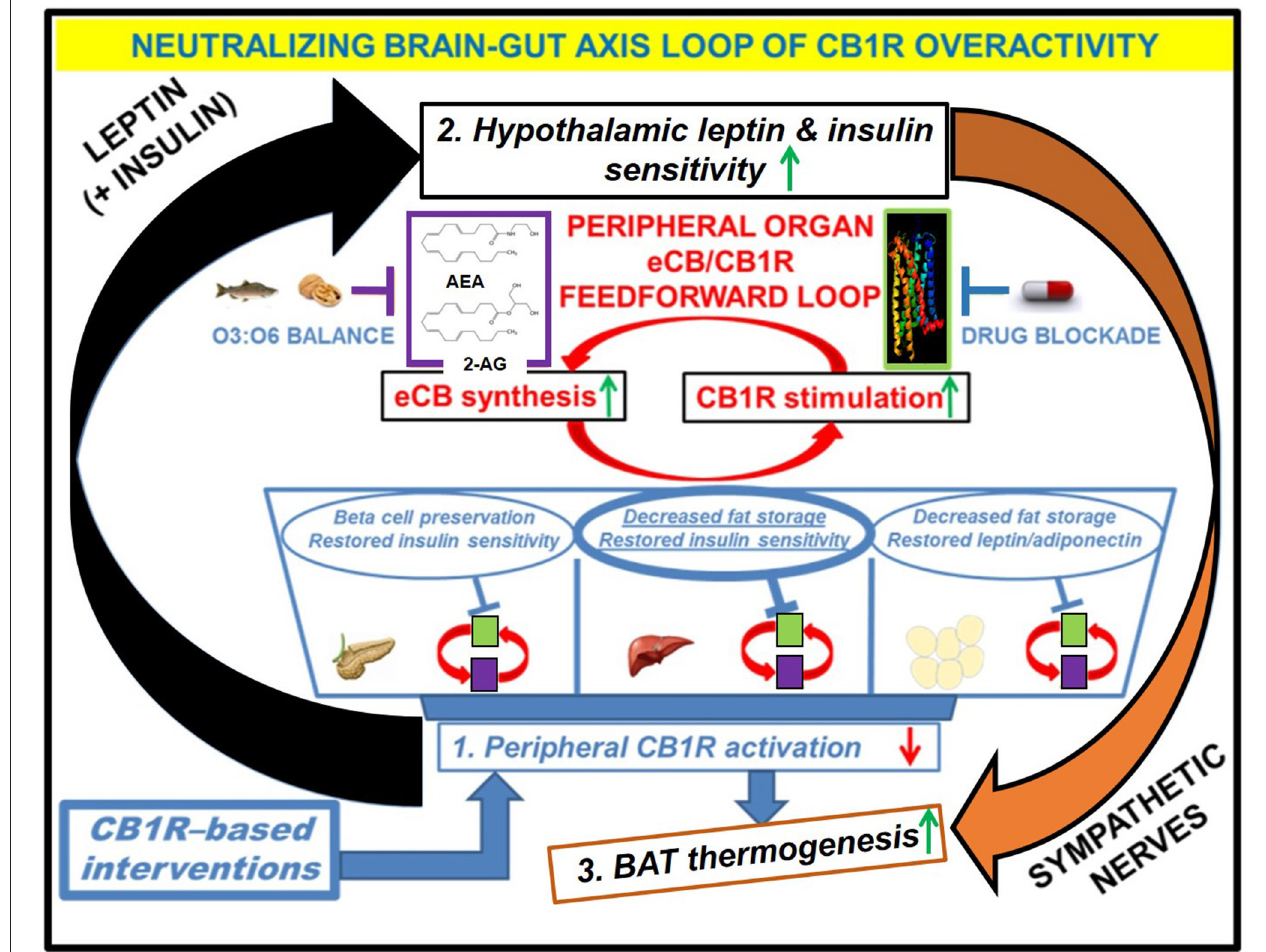
FIGURE 3 | Downstream effects of peripheral CB1R blockers on the restoration of CB1R-LepR-MC4R axis homeostasis. Administration of the drug would have direct effects on the “feed-forward” loops of eCB/CB1R overactivity present in the peripheral organs of metabolic disease patients. The purple and green boxes linked cyclically by the red arrows represent a zoomed-in view of how various eCB/CB1R system-based interventions alleviate metabolic dysfunction within individual organs. The drug would directly bind to CB1Rs in peripheral tissues and prevent binding of endogenous eCBs. Increased consumption of Omega-3 fatty acids relative to Omega-6 fatty acids, either via whole foods or by supplementation, can augment the drug’s efficacy via reduction of eCB ligand synthesis. The downstream effects of inhibiting the peripheral CB1R stimulation (1, blue box) would manifest as increased sensitivity to both leptin and insulin within the hypothalamus (2, black box), despite a likely reduction in the plasma levels of these hormones. Because the hypothalamus exerts top-down control over peripheral and central energy homeostasis, there would be additional downstream effects produced by alterations to the sympathetic nervous system, notably an increase in BAT thermogenesis (3, orange box). Importantly, the increased “browning” of WAT promoted by CB1R blockade (blue arrow from box 1 to box 3) would synergize with these centrally mediated effects to increase overall energy